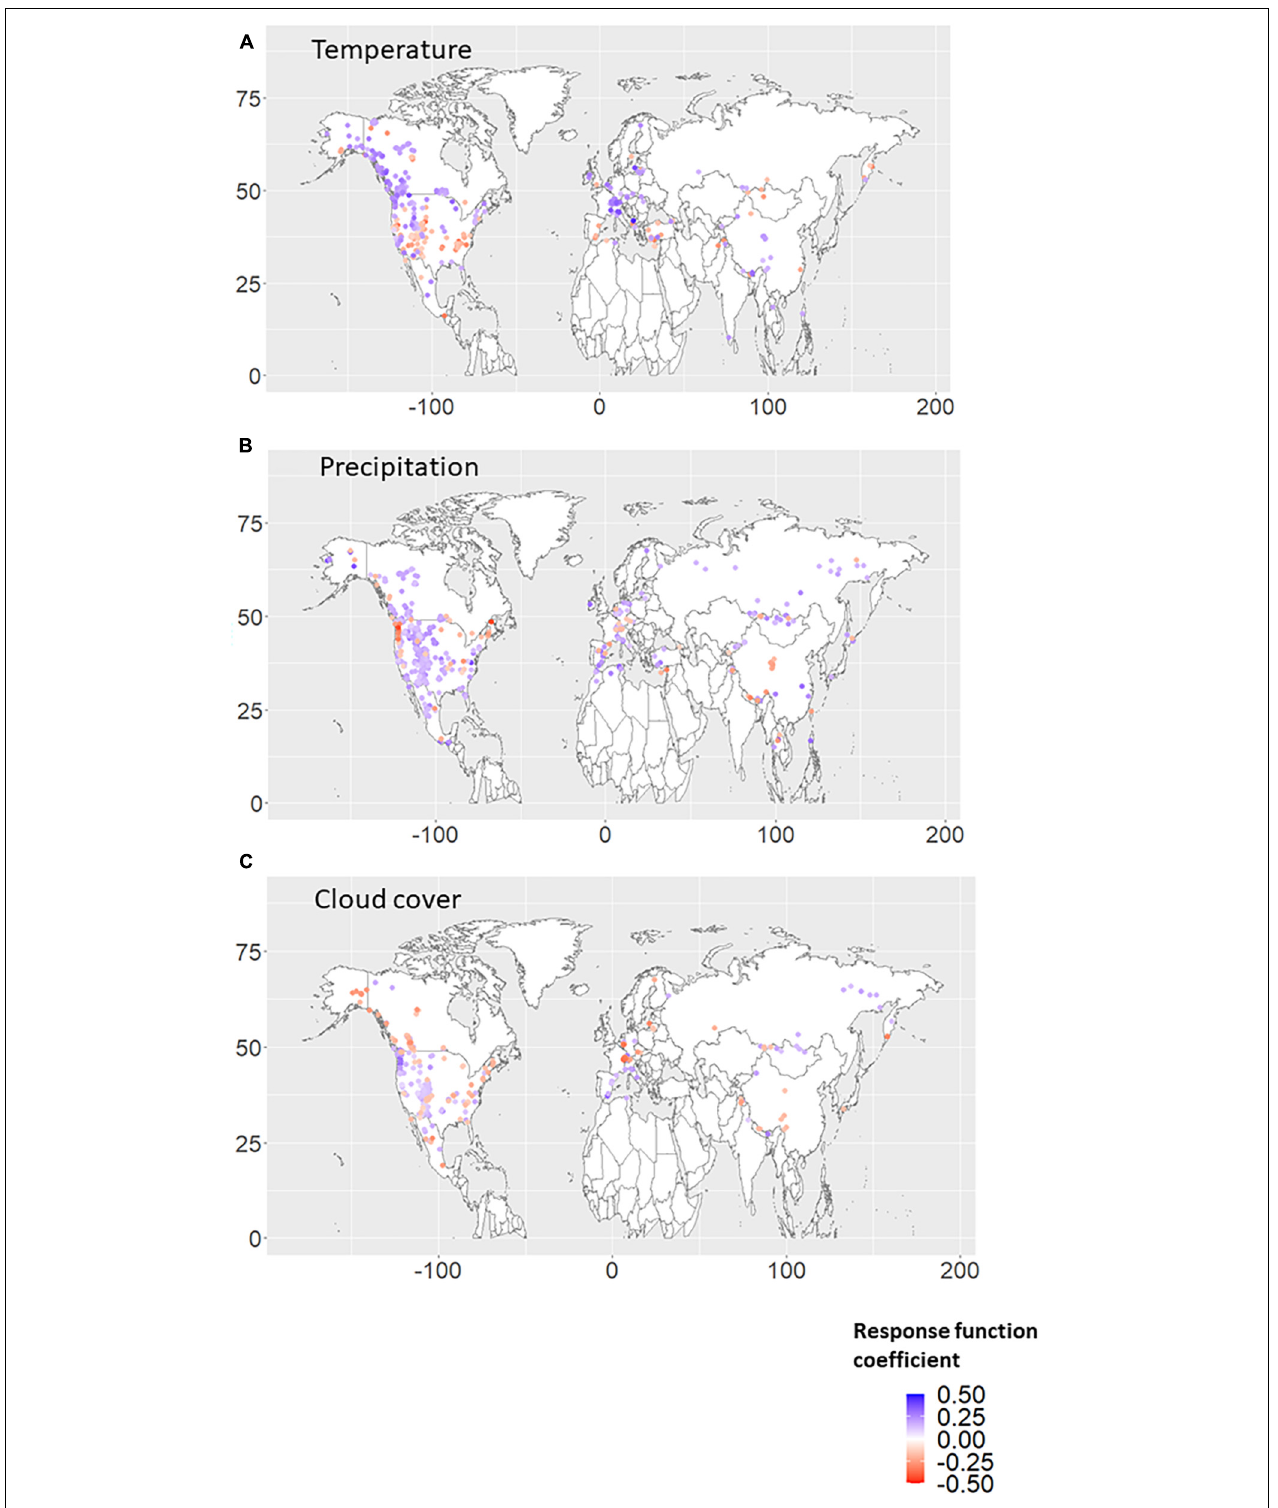
FIGURE 1 | Response function (RF) coefficients between RWI and climate variables, i.e., (A) temperature, (B) precipitation, and (C) cloud cover, in the autumn season. The period when both RWI and climate data existed in duplicate during 1901–2016 was used for the analysis. Only the RWI sites where the RF coefficient was significant ( p < 0.10) are plotted. Climate conditions from the current autumn and previous autumn were used for the RF analysis. If RF coefficients were significant in both the previous and current autumn, the larger absolute value is plotted.